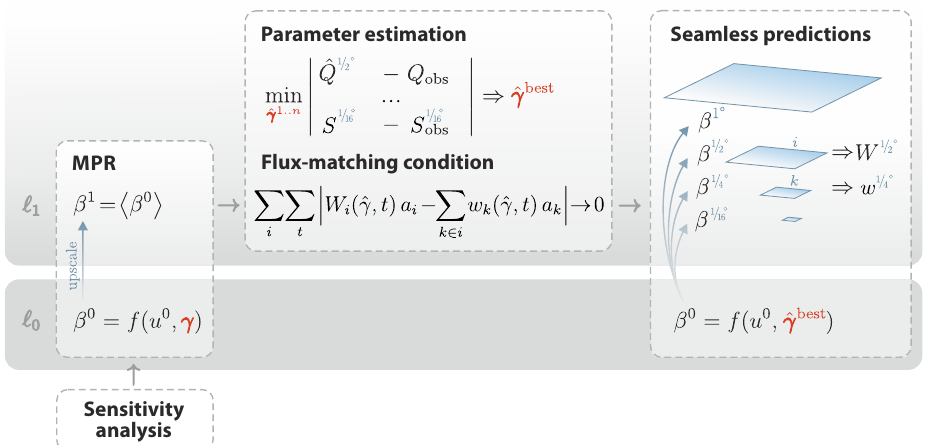
Figure 2. Schematic representation of the proposed seamless prediction framework based on Rakovec et al. (2016b). It includes a preliminary sensitivity analysis, MPR estimation, global-parameter estimation, a flux-matching test, and multiscale seamless prediction. W i and w k are the fluxes at the i and k cells of the 1 / 2 ◦ and 1 / 4 ◦ resolutions, respectively (as an example). Q obs and S obs are the observed time series of streamflow and soil moisture, respectively. The operator |·| is a compromise dissimilarity metric composed of many independent observations at various